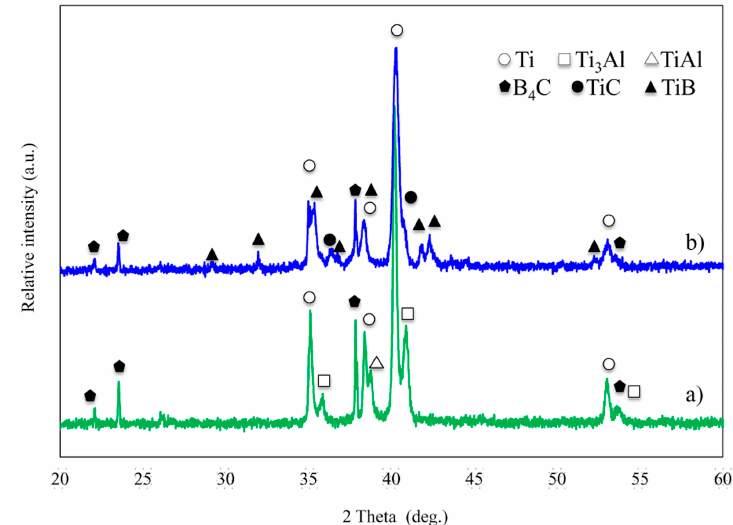
Figure 7. XRD patterns of the Ti matrix with 20 vol % of TiAl and 30 vol % of B 4 C produced during 5 min via inductive hot pressing at different temperatures: ( a ) 1000 °C; and ( b ) 1200 °C.